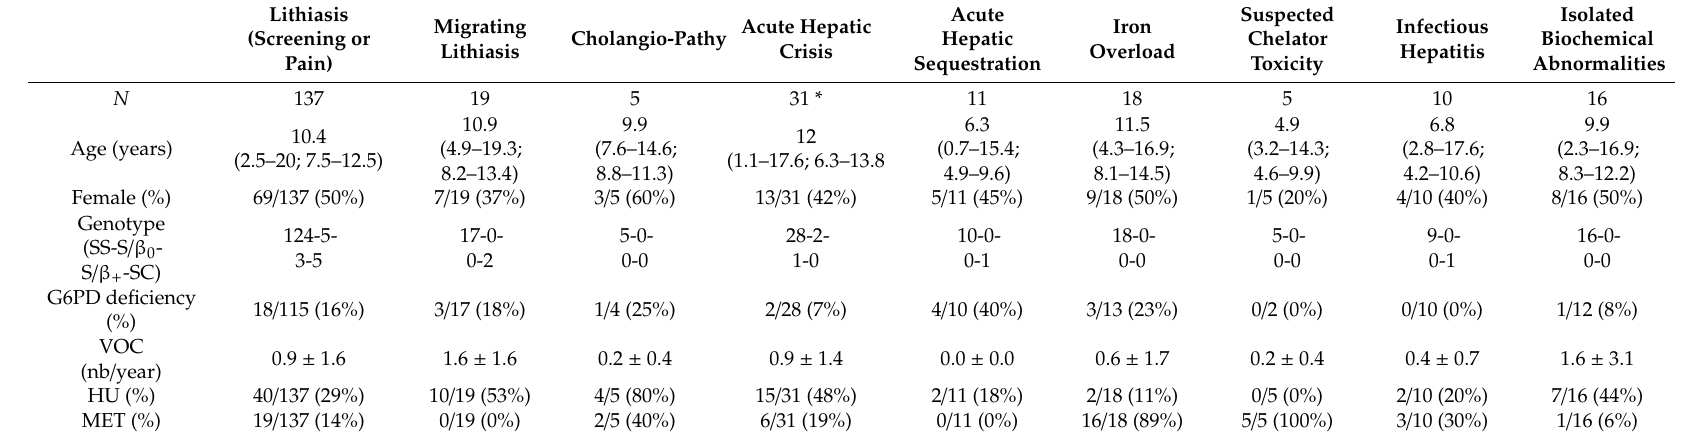
Table 1. Clinical characteristics of patients with hepatobiliary